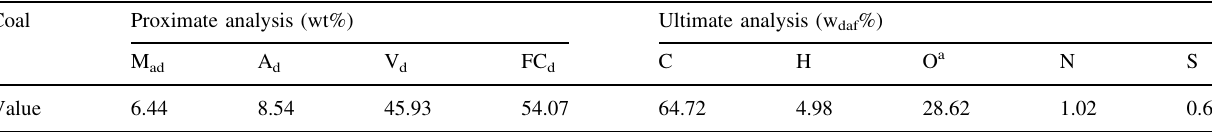
Table 1 Proximate and ultimate analysis in the Shengli brown coal